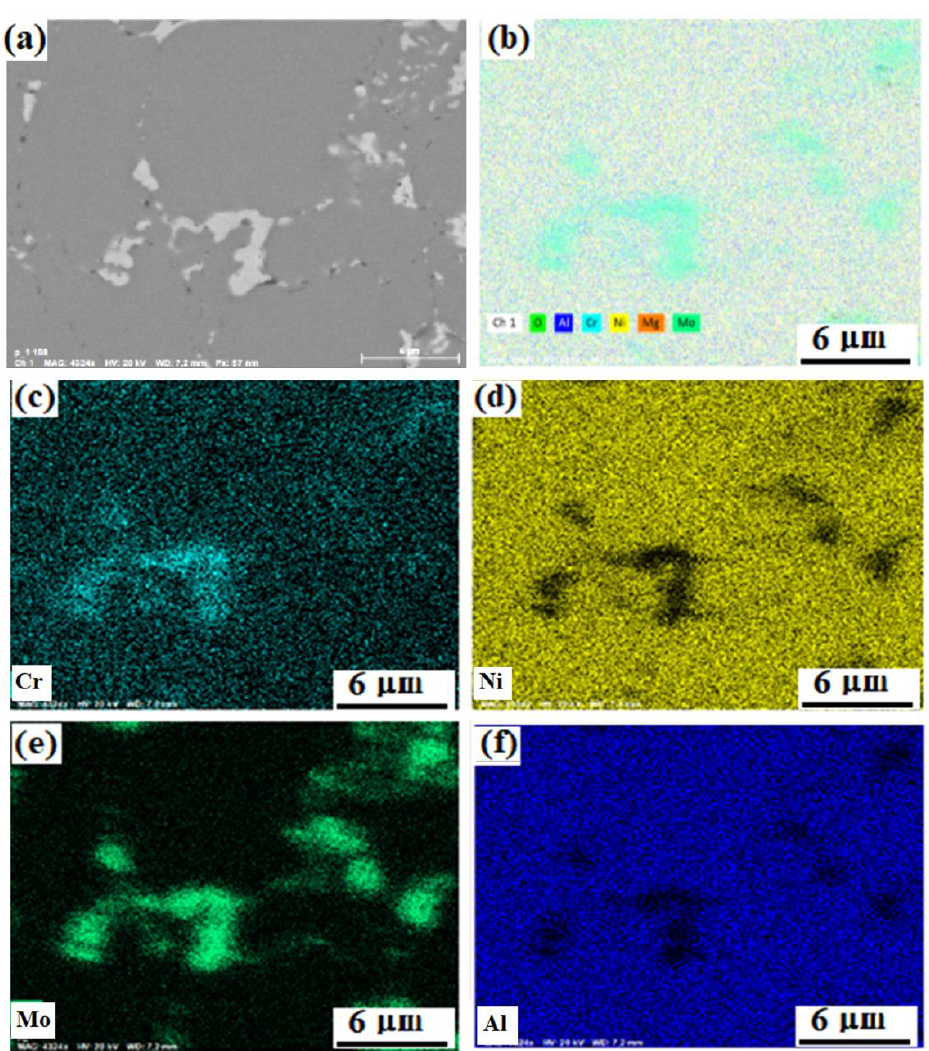
Figure 7. Distribution of elements in the structure of the composite M-0.01 wt.% of MgAl 2 O 4 : SEM backscattered electron image of the study region ( a ), summary map of the elements distribution ( b ), distribution maps of Cr ( c ), Ni ( d ), Mo ( e ), Al ( f ).